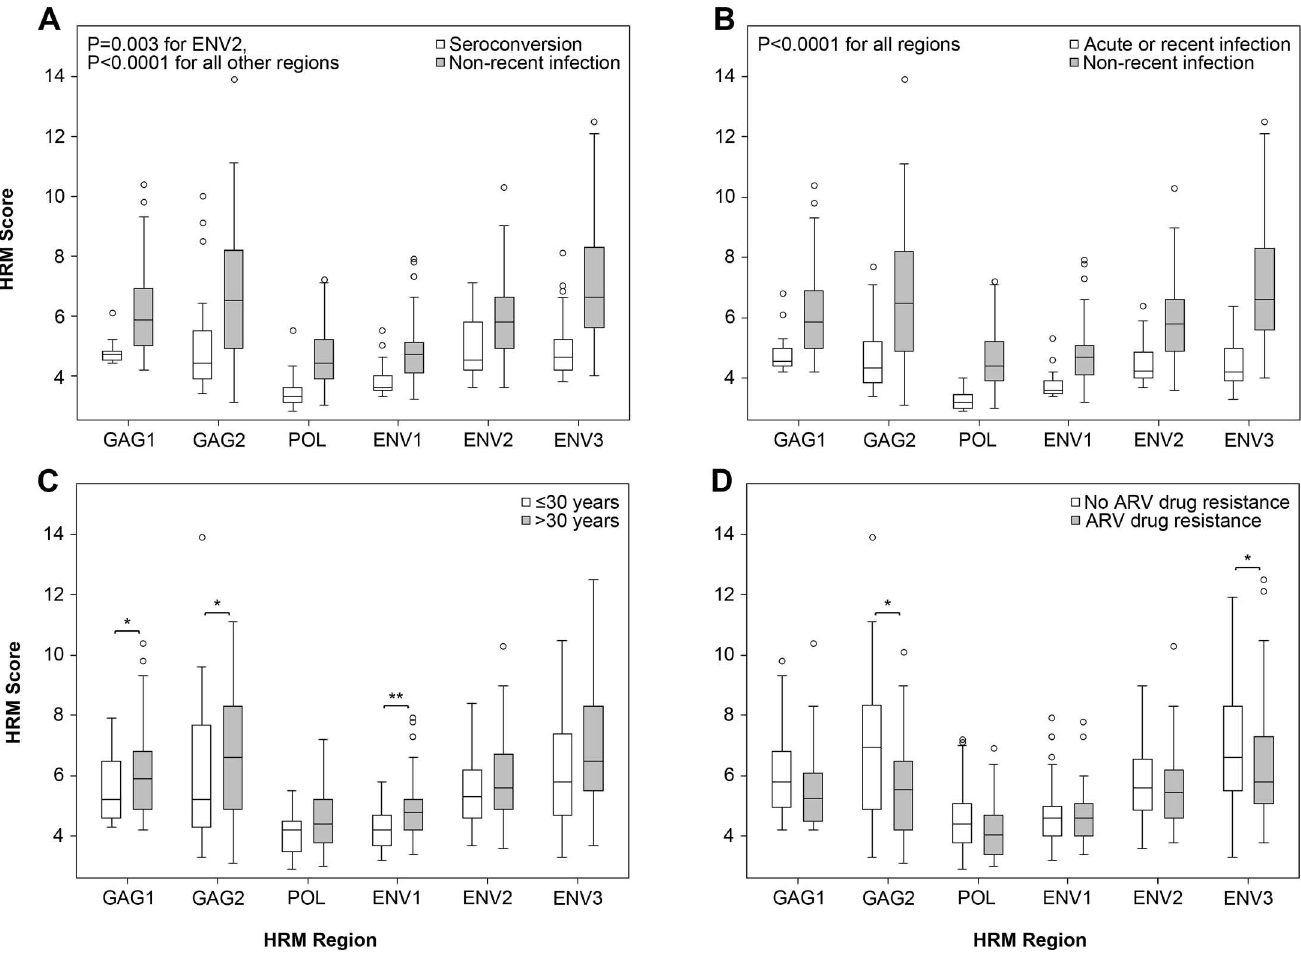
Fig 2. HRM scores for men who were HIV infected at enrollment and men who seroconverted during the HPTN 061 study. Box and whisker plots show the distribution of high resolutionmelting(HRM) scores for six regions in the HIV genome.Data are shown for men in different subgroups (acute infectionat enrollment,recent infectionat enrollment,non-recent infection at enrollment;seroconverters; see text). Symbols show the median (inner line), interquartile range (box), lower inner and upper outer fences (whiskers), and outliers (circles) for HRM scores. Univariatemedianregression analyseswere used to compareHRM scores betweenthe indicatedgroups; p -values for these comparisons are shown ( * p < 0.05; ** p < 0.01).